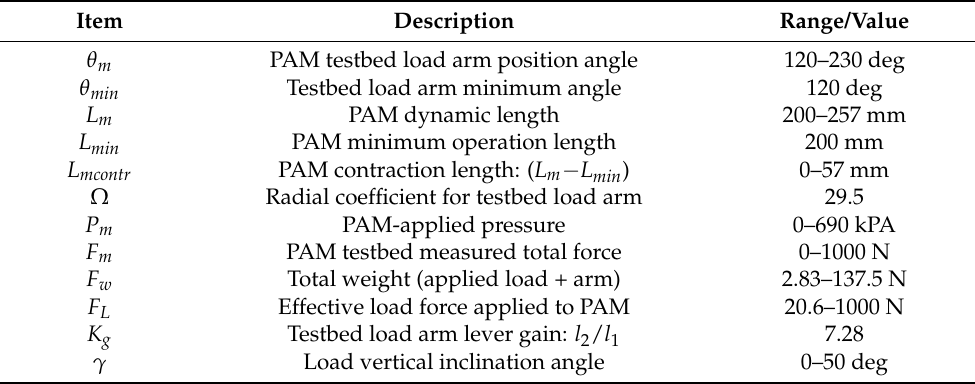
Table 2. 1 DoF PAM testbed physical quantities andoperation